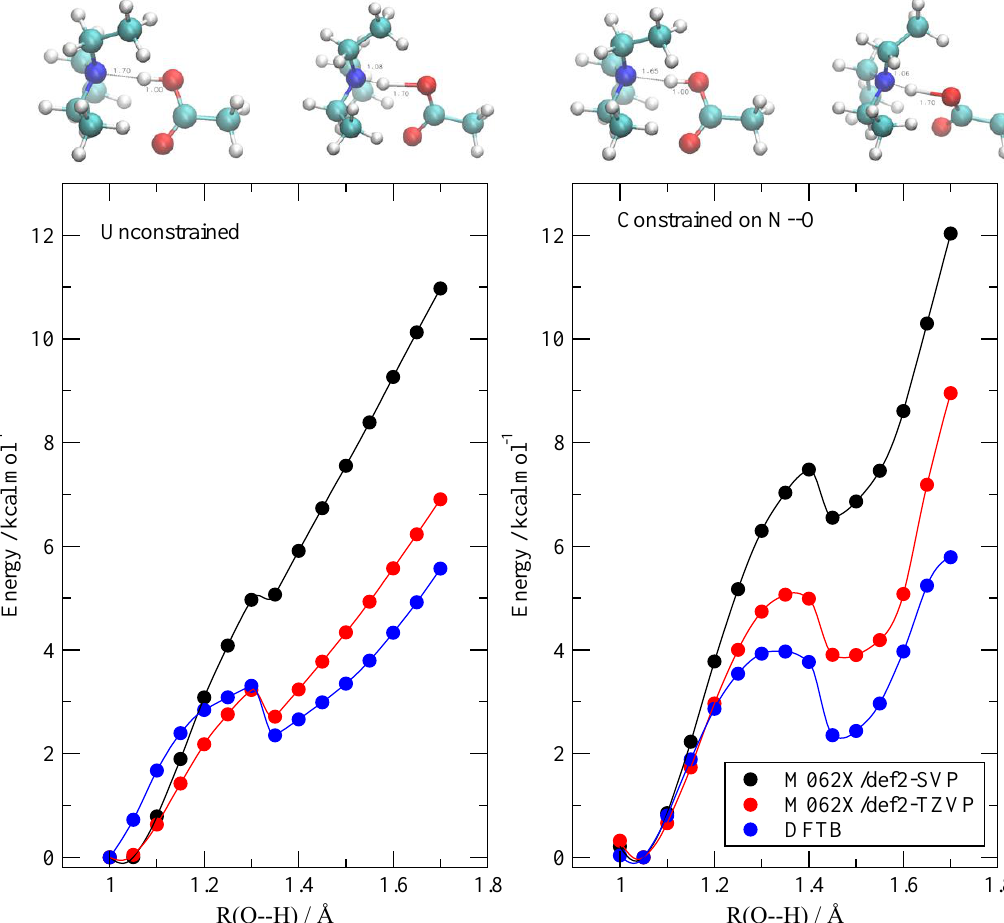
Figure 2. Energy profile of the AcOH / TEA pair as a function of the AcO–H distance (see text for details). The black dots are the M062X / def2-SVP optimized energies. The red ones are M062X / def2-TZVP single point energies, and the blue ones are the density functional tight binding (DFTB) results. Left: scan without any further constraint except the O–H distance. Right: scan with an additional constraint that keeps the N–O distance fixed at its equilibrium value. To allow for comparison, the minimum energy in each set was set equal to zero. The structures on top correspond to the first and last geometries in each scan.